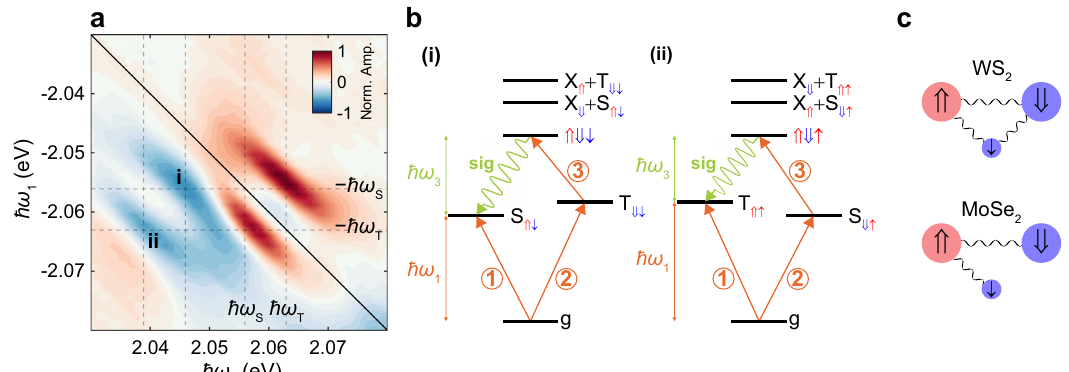
Fig. 4 | Origin of the bipolaron peaks in the 2D spectrum. a Real part of the complex 1Qrephasing spectrum from Fig. 2d. Positive peaks arise from stimulated emission pathways (red), while negative peaks appear due to excited state absorption pathways (blue). Color scaling represents the normalized real signal amplitude (Norm. Amp.). S and T absorption/emission energies ( ℏ ω S and ℏ ω T , respectively) are marked with dashed lines. The negative peaks arising from the bipolaronareshiftedin ℏ ω 3 by17meVfrom ℏ ω S and ℏ ω T . b Excitedstateabsorption energy leveldiagrams showing the pathways which contribute to the i and iipeaks